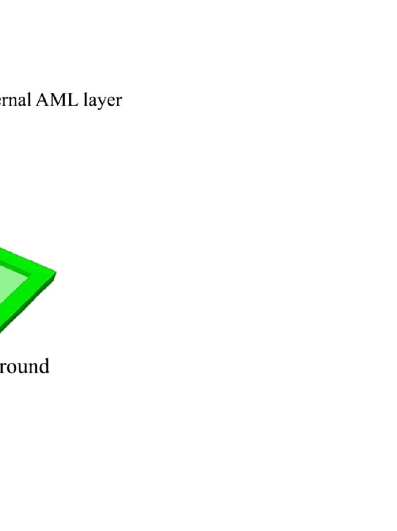
Figure 12. External sound field